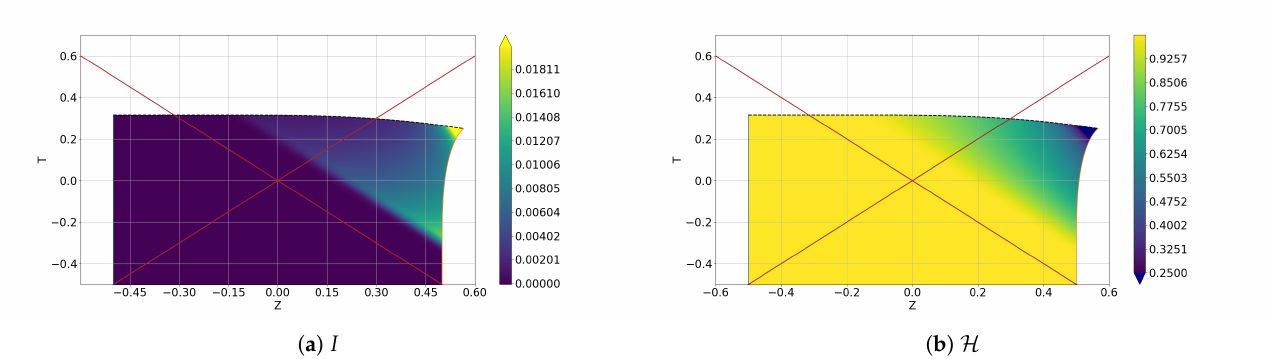
Figure 3. Two diagrams showcasing how the vectors l a , n a , ∂ a when a future singularity occurs.